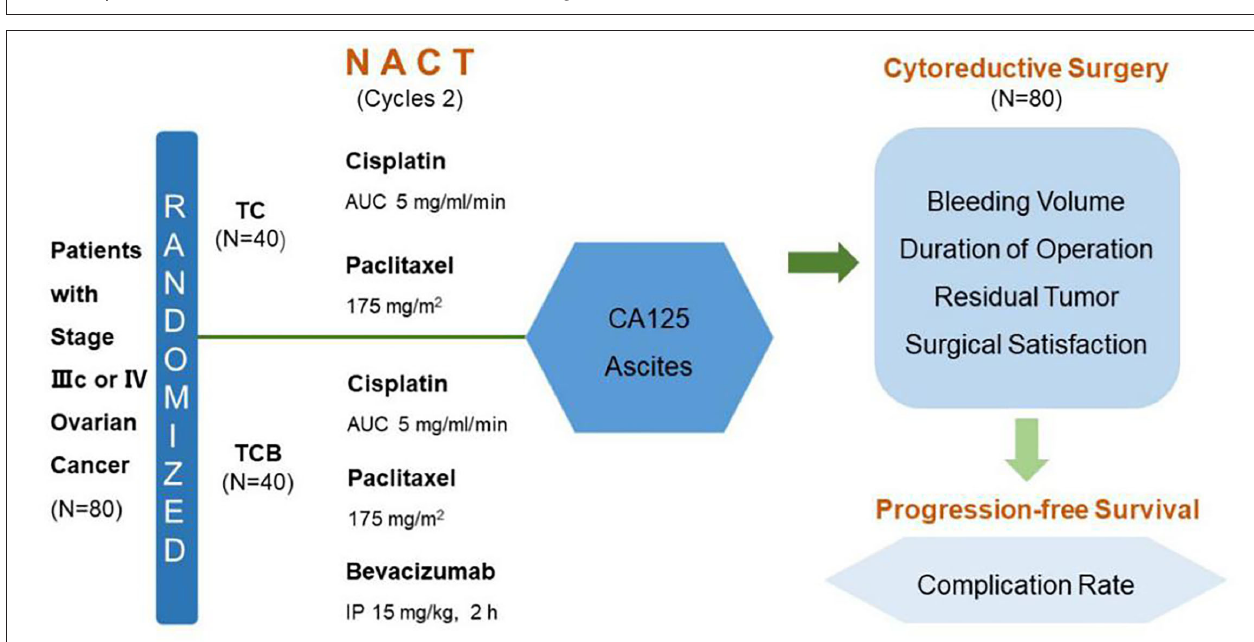
FIGURE 1 | Global incidence of ovarian cancer in 2020. ASR indicates age-standardized rate.